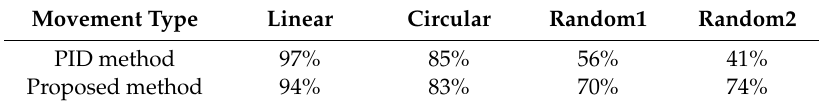
Table 5. Landing success rate for several movement